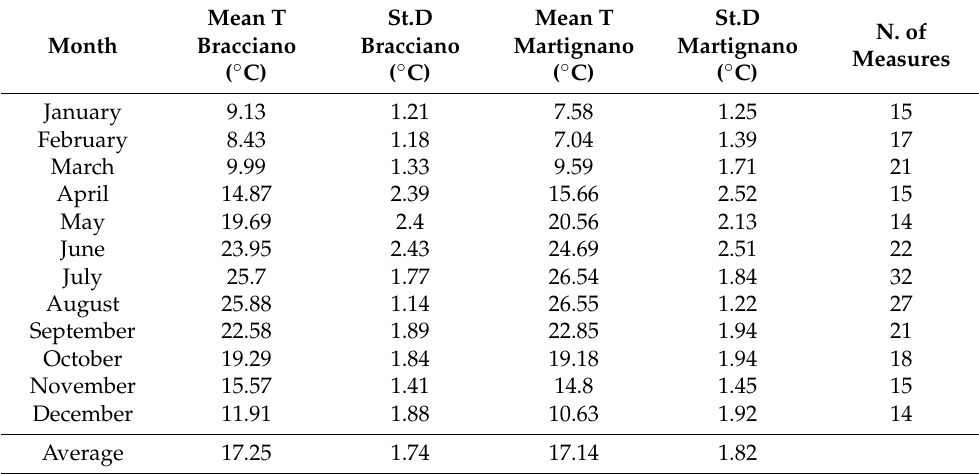
Table 6. Average year derived from Landsat data acquired from 1984 to 2019 using our proposed approach for the atmospheric correction of Landsat